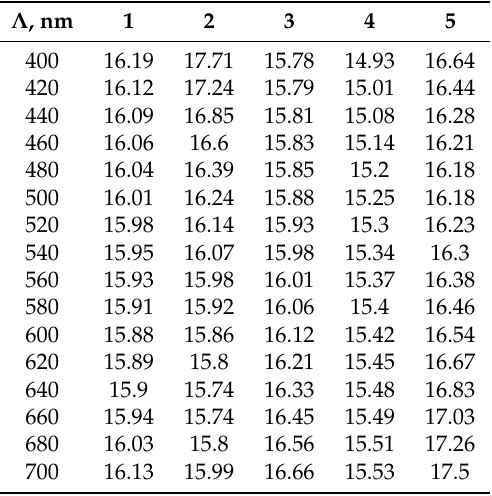
Table 3. Coefficients of reflection of the Cr-V spinel group minerals from the Kola region. Table 3. Coe ffi cients of reflection of the Cr-V spinel group minerals from the Kola region.